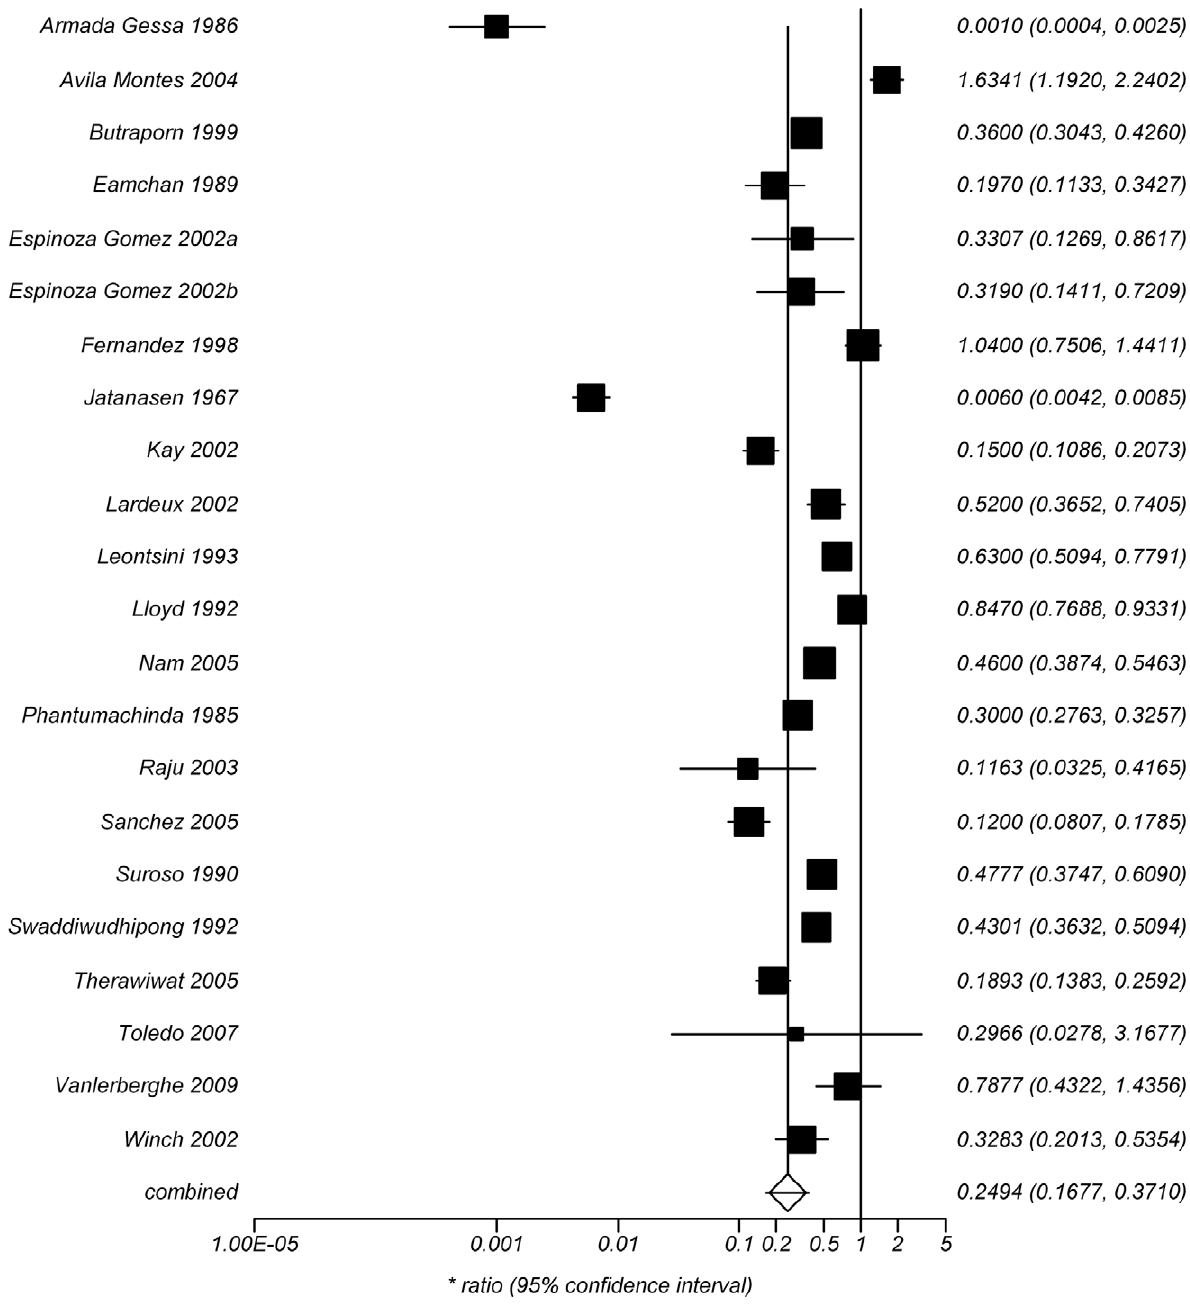
Figure 2. Performance of educational, chemical and other interventions, against dengue vector outcome measures. * The diamond represents the combined relative effectiveness (RE); squares represent the RE of individual studies; the size of the square represent the weight given to the study in the meta-analysis; and the horizontal lines represent the 95% confidence limits. Risk Ratio equates to Relative Effectiveness, values of , 1 indicate lower entomological indices in the intervention compared to the control arm. The lower the value the more effective the